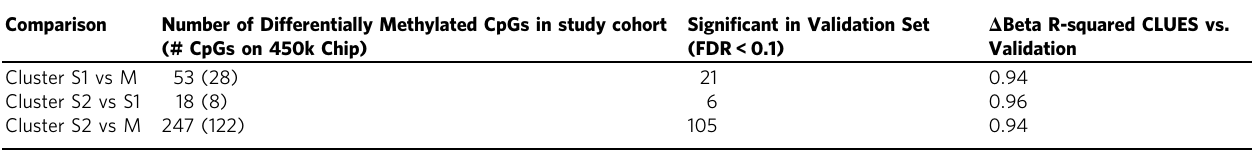
Rows indicate individual pairwise comparisons as performed using the nestedF method in ethnicity 1000 times and testing for association with ethnicity.